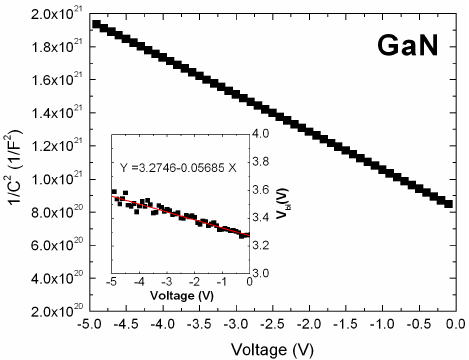
Figure 2. Plot of 1 / C 2 (V) dependence of the PIN-diode based on the GaN reference [44] (inset: V bi deduced from 1/C 2 (V) of GaN reference). Group-III nitride semiconductors possess direct band gaps over a large energy range. It is the ability to create direct gap ternary alloys such as In x Ga 1-x N, Al x Ga 1-x N or In x Al 1-x N with energies beyond those of the constituent binary III nitrides that makes them profitable for use in optoelectronic devices. A band diagram of the wurtzite (WZ) crystal structure [33] in a simplified E(k) representation at k = 0 ( Γ -point) involves a non-degenerate conduction band (CB) and three separate valence split bands (VBs) upon degeneracy removal due to the hexagonal crystal field Δ cr and the spin–orbit interaction Δ so , as demonstrated in Figure 3 (left side). In reality, the bands extend over a larger range of momentum with non-parabolic dispersions and there may also be more than one confined states for both the CB and VBs. The top of the valence band is split into twofold- and single-degenerate states originated by the hexagonal crystal field Δ cr ; the former is labeled Γ 6 and the latter Γ 1 [61–63]. In case of GaN, Γ 6 is higher than Γ 1 , while in case of AlN, the Γ 1 level is higher. The two-fold degenerate Γ 6 state is split into Γ 9 and Γ 7 by the spin–orbit interaction Δ so ; the single degenerate state has also Γ 7 symmetry. Hence, the two Γ 7 states are mixed by the spin–orbit coupling. The hole masses of the three states: Γ 9 , Γ 7+ , and Γ 7 − have a large k dependence [61,62], and are labeled HH (heavy-holes), LH (light-holes), and CH (or SO) (crystal field split-off holes) [62,64],